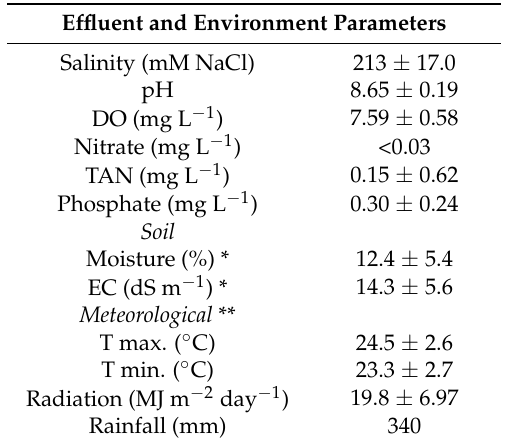
Table 1. Average ( ± standard deviation) conditions of effluent (salinity, pH, dissolved oxygen—DO, nitrate, total ammonium nitrogen—TAN and phosphate), soil (moisture and electrical conductivity—EC) and meteorological data (maximum and minimum temperatures, solar radiation, and accumulated rainfall) during the field